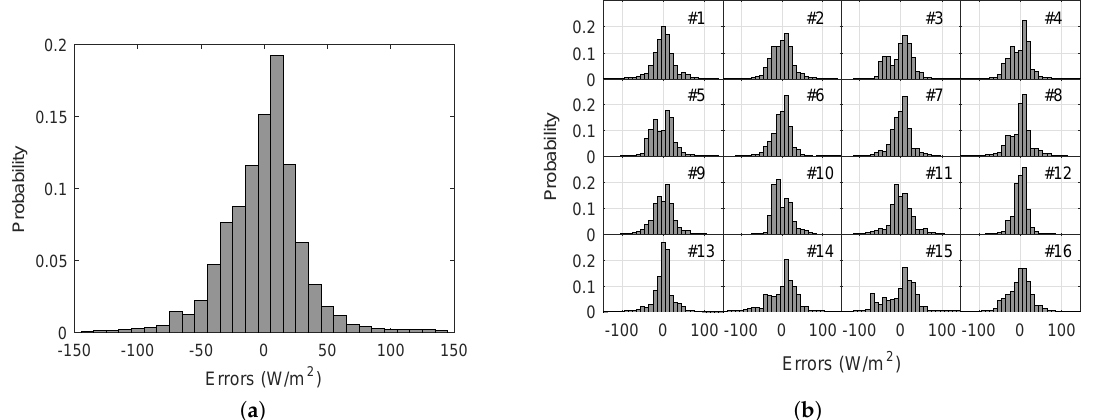
Figure 5. Aggregated error distribution including the 16 motes ( a ); and error distributions for each mote according to the network layout ( b